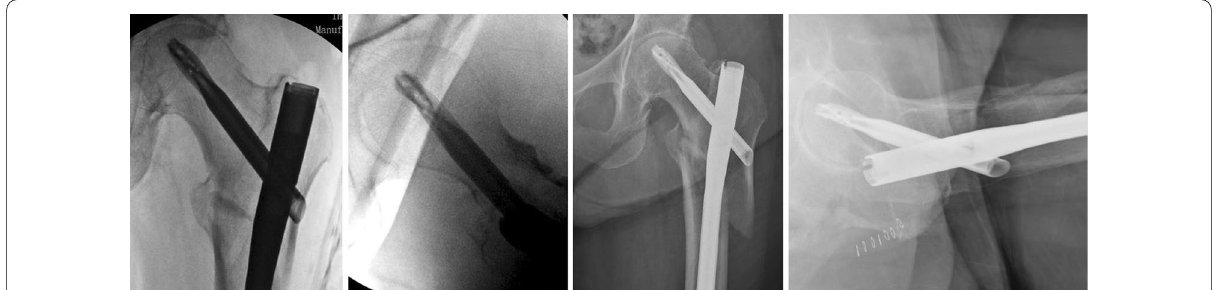
Fig. 1 Pictured left are the AP and lateral views of the hip obtained following the index procedure. Pictured right are the repeat radiographs taken 2 weeks postoperatively that show interval displacement of the fracture, loss of reduction, and shortening of the proximal